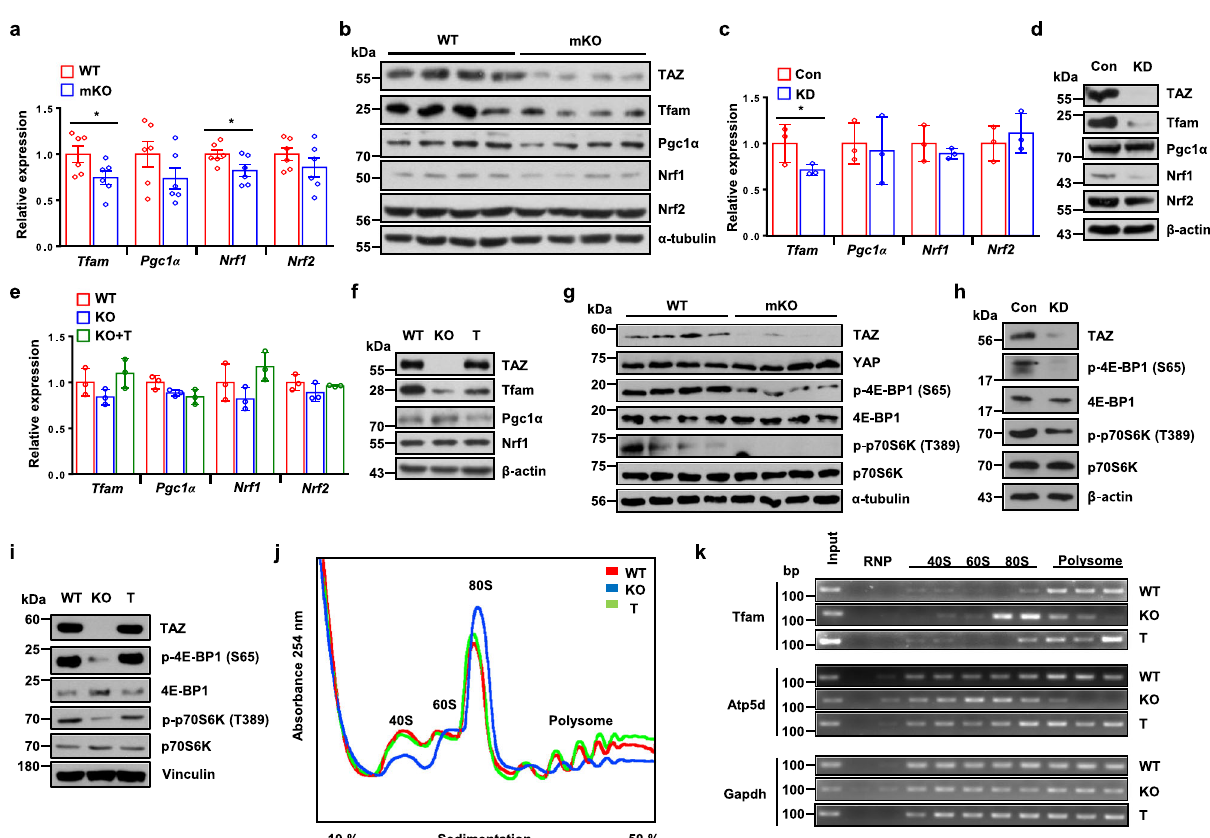
Fig. 2 TAZ induces Tfam protein expression at the translational level. a The expression of mitochondrial biogenic factors, including Tfam , Ppargc1a (Pgc1 α ) , Nrf1 , and Nrf2 , was analysed using quantitative reverse transcription (qRT)-PCR in the gastrocnemius muscle of wild-type (WT) and muscle- speci fi c TAZ knockout (mKO) mice; n = 6 for each condition ( Tfam ; * p = 0.0498, Nrf1 ; * p = 0.0467). b Protein was analysed via immunoblotting to detect TAZ and the indicated mitochondrial biogenic factors in ( a ). Alpha-tubulin was used as the loading control. c RNA was isolated from the control (Con) and TAZ knockdown (KD) C2C12 myotubes, and the expression of the indicated mitochondrial biogenic factors was analysed using qRT-PCR. The experiments were performed in triplicate ( Tfam ; * p = 0.04). d Protein from the Con and TAZ KD C2C12 myotubes was assessed via immunoblotting to detect TAZ and mitochondrial biogenic factors. Beta-actin was used as the loading control. e RNA was isolated from WT, TAZ-knockout (KO), and TAZ-rescued (T) mouse embryonic fi broblasts (MEF), and the indicated mitochondrial biogenic factors were analysed via qRT-PCR. f Protein from WT, KO, and T MEF was assessed via immunoblotting to detect TAZ and the indicated mitochondrial biogenic factors. Beta-actin was used as the loading control. g Protein was isolated from the gastrocnemius muscle of WT and mKO mice and analysed via immunoblotting to detect TAZ, YAP, and proteins involved in the translation of both phosphorylated and total forms. Alpha-tubulin was used as the loading control. h Protein obtained from the Con and TAZ KD C2C12 myotubes was assessed via immunoblotting to observe TAZ and proteins involved in translation. Beta-actin was used as the loading control. i Protein was isolated from WT, KO, and T MEF and analysed via immunoblotting to detect TAZ and proteins involved in translation. Vinculin was used as the loading control. j The polysome pro fi le of cells described in panel i was evaluated continuously by measuring absorbance at 254 nm. The 40S, 60S, 80S, and polysome fractions are denoted by the corresponding peaks. k The distribution of Tfam , Atp5d , and Gapdh mRNA from cells described in ( j ) across a density gradient was analysed using reverse transcription (RT)-PCR. bp = base pairs. For a , b , g 8 to 10-week-old mice were used. Data are presented as mean ± SEM for ( a ), mean ± SD for ( c , e ). Statistical signi fi cance was analysed via two-sided t -test for ( a ) and one-sided t -test for ( c ). One-way ANOVA with Tukey ’ s multiple comparison test was used for ( e ). Representative data was shown and experiments were performed at least twice with similar results for ( b , d , f – i , k ). Source data are provided as a Source data fi